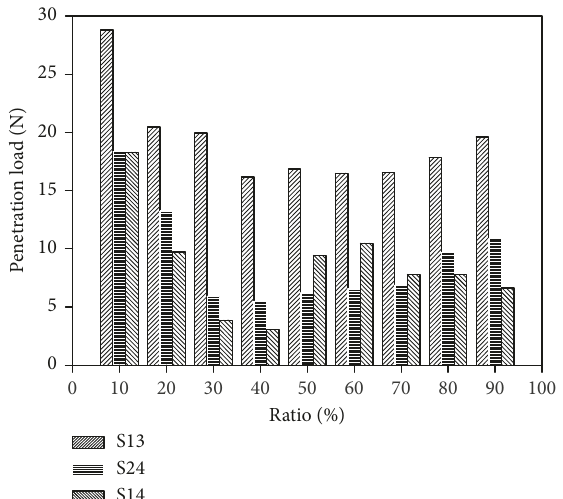
Figure 11: Penetration loads of three kinds of two-aggregate mixtures with gap gradation at the penetration displacement of 6mm.